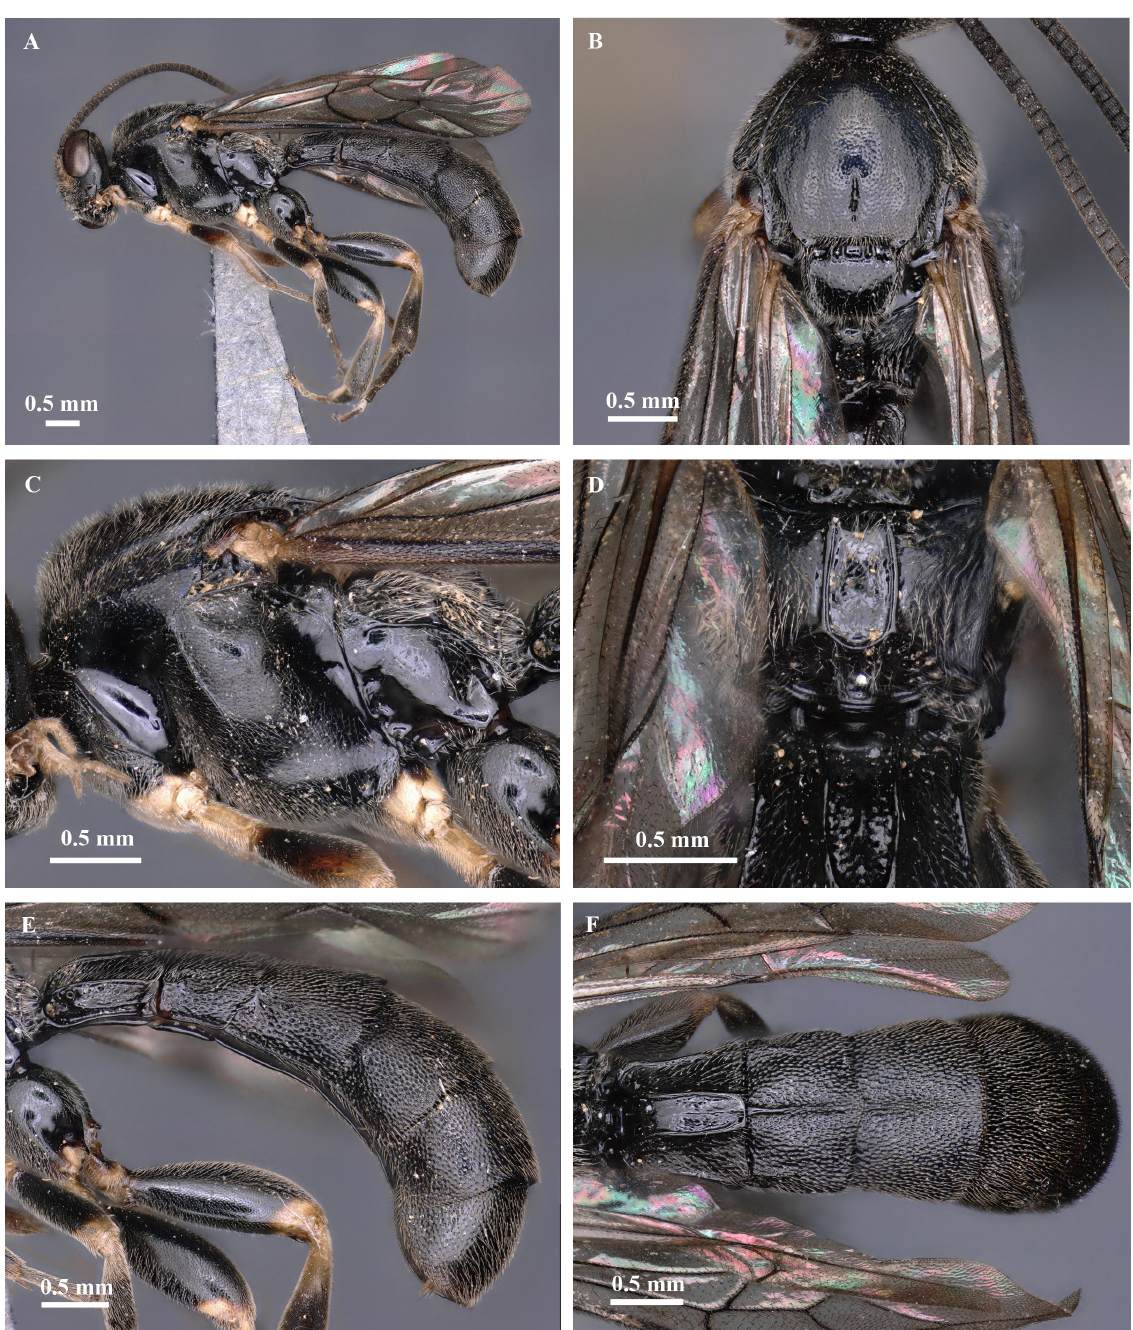
Fig. 7. Chorinaeus sp., ♂ (AIMB). A . Habitus, lateral view. B . Mesosoma, dorsal view. C . Mesosoma, lateral view. D . Propodeum, dorsal view. E . Metasoma, lateral view. F . Metasoma, dorsal